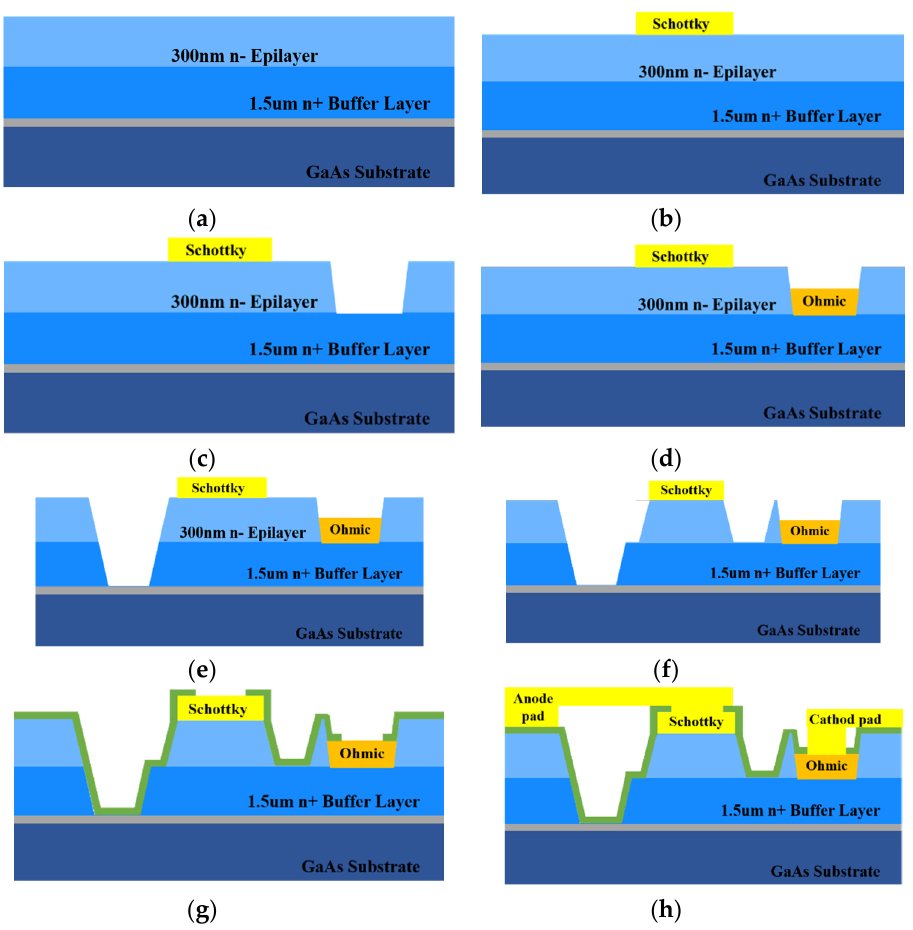
Figure 2. The fabrication process of the Schottky diode based on the gallium arsenide process of the Institute of Microelectronics, Chinese Academy of Sciences. ( a ) Epitaxial wafer preparation, ( b ) Schottky metal deposition, ( c ) ohmic definition, ( d ) ohmic contact fabrication, ( e ) Mesa separation, ( f ) Schottky terminal structure formation, ( g ) passivation, ( h ) Interconnect metal and airbridge electroplating. Table 1. The simulated and measured parameters of the Schottky diodes used in the design of the frequency multipliers. In the table, s and m represent simulated and measured results, respectively.